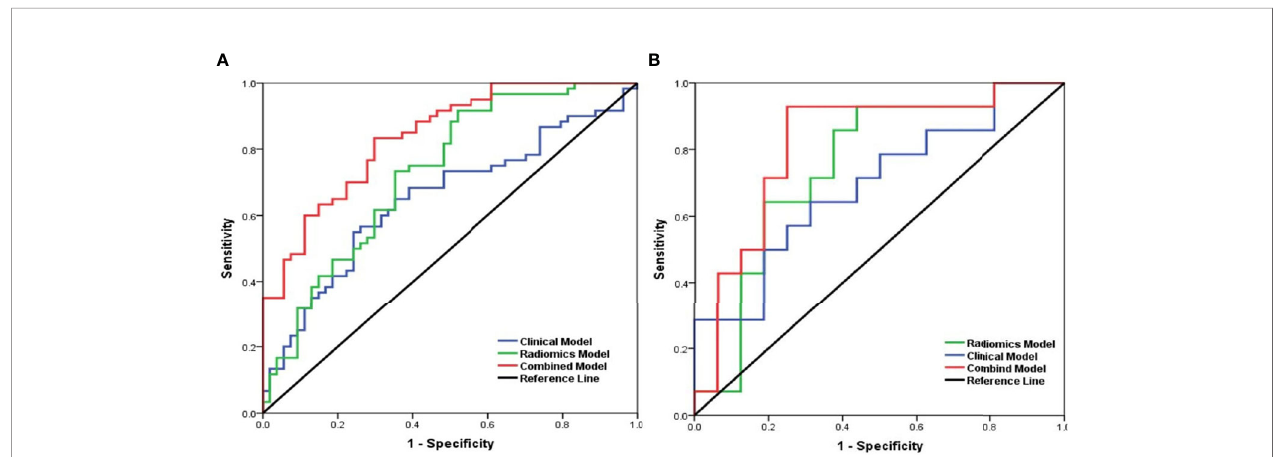
FIGURE 2 | Receiver operating characteristic (ROC) curves of the biomarkers for classifying programmed death-ligand 1 (PD-L1) expression level based on clinical factors alone (blue), radiomics features alone (green), and a combined model that combined clinical and radiomics features (red) in the training set (A) and validation set (B)